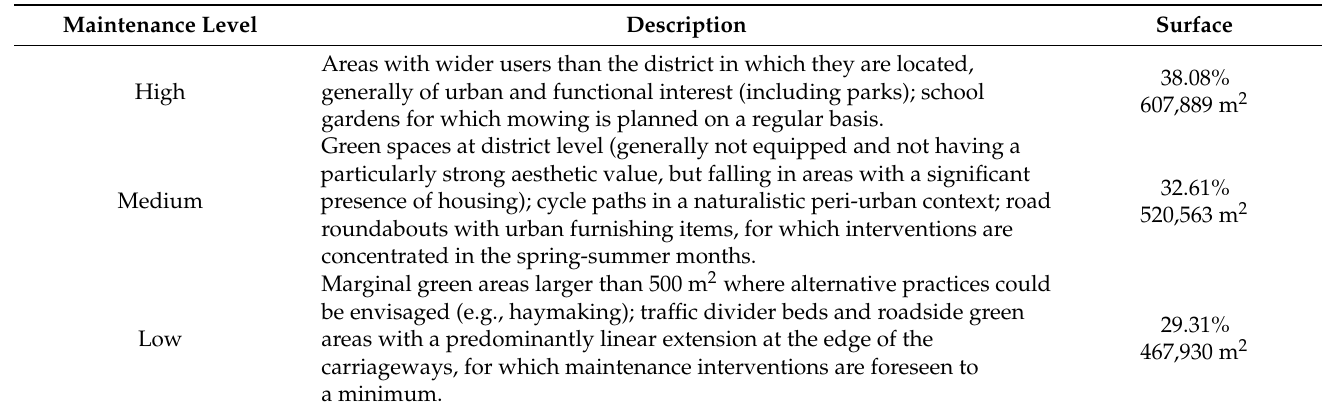
Table 7. Maintenance Levels (ML) for a differentiated management of the areas as reported by the National Committee of Green Public Areas [46].